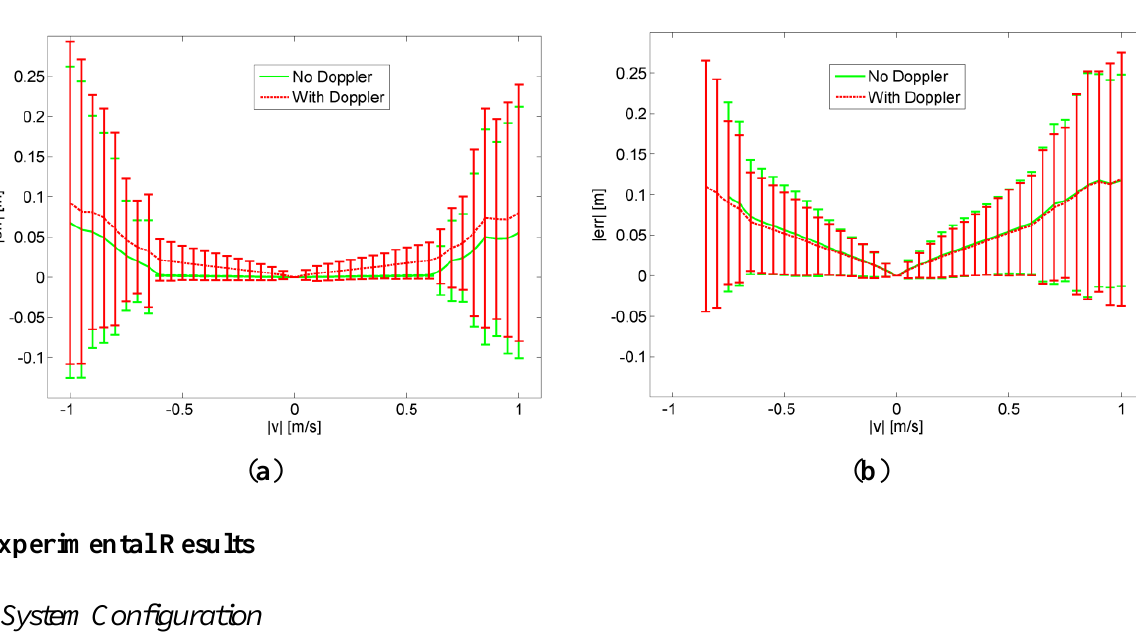
Figure 10. Simulation Results: ( a ) Effect of receiver motion with 0 ms interface spacing (only possible in CDMA system), ( b ) Effect of receiver motion with 10 ms interframe spacing suitable for LPS LOSNUS with up to 3.4 m minimal spacing between consecutively firing